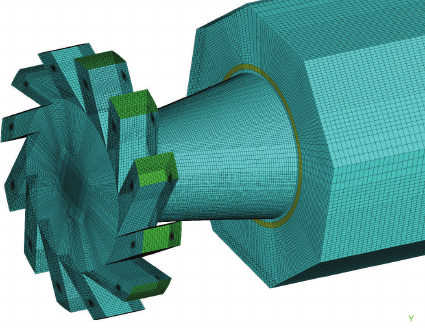
Figure 2: The mesh (detail view of surface